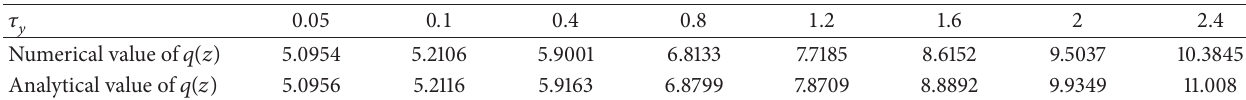
Table 2: A comparison between numerical value of pressure gradient and approximate value of pressure gradient at the midpoint of dilatation region for different values of yield stress taking 𝑛 = 0.8, 𝑘 = 1.2, 𝜁 = 0.01 , and 𝛿 2 = −0.2 . 𝜏